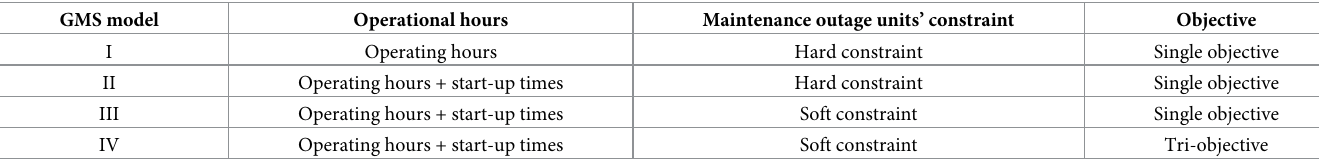
Table 6. GMS model enhancement